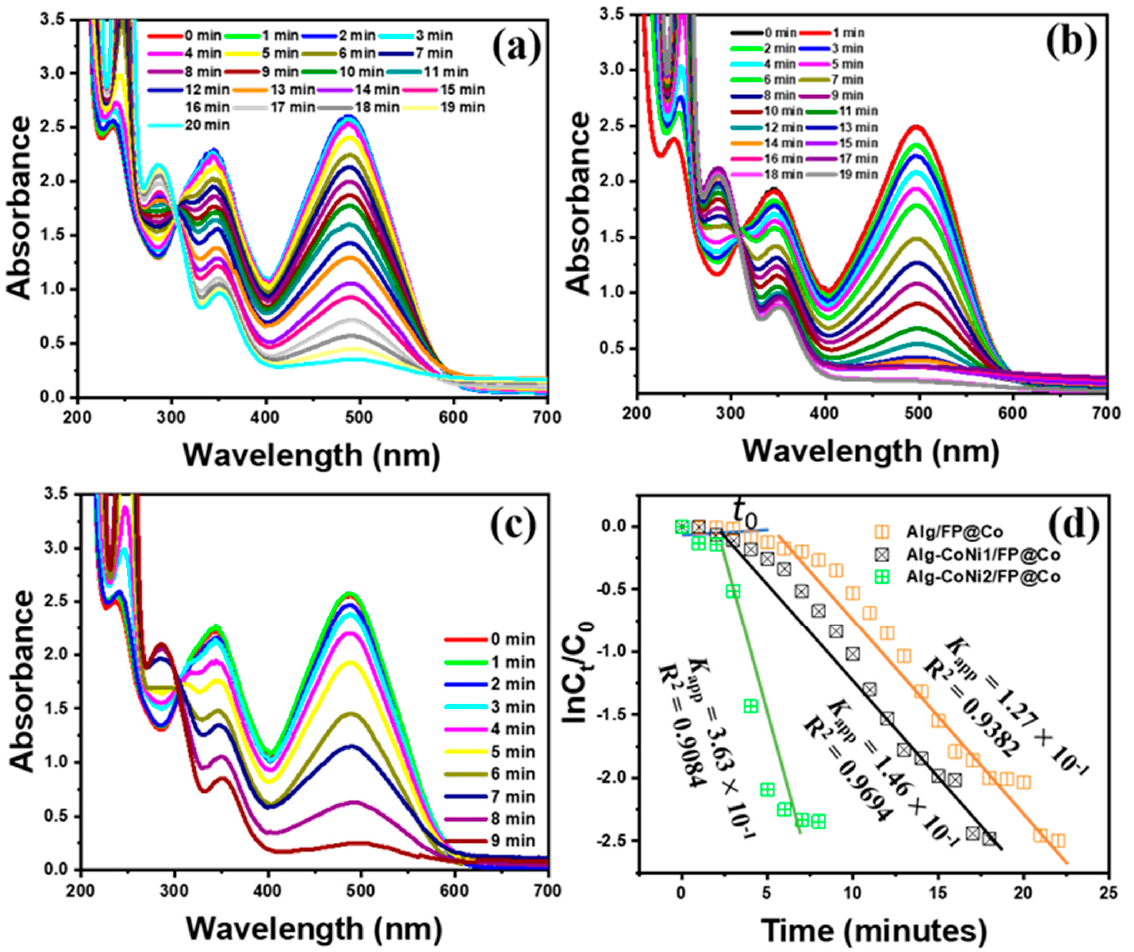
Figure 3. UV-Vis. absorbance spectra of CR dye discoloration in the presence of NaBH 4 using Alg/FP@Co ( a ), Alg- CoNi1/FP@Co ( b ), Alg-CoNi2/FP@Co NPs ( c ), and linear relationship of pseudo-1st order kinetics ( d